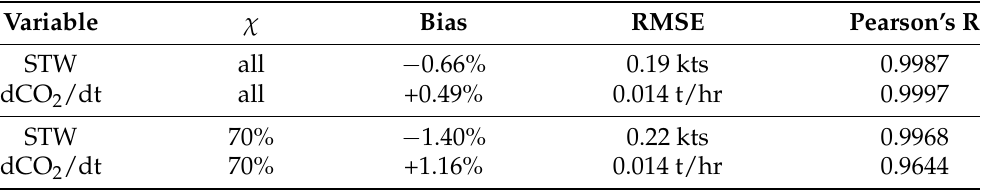
Table 4. Quality assessment of the multi-dimensional model of the vessel response function with respect to the simulator datapoints. Both the metrics for the entire set of datapoints (315 values) and for a specific engine fractional load χ value (45 values) are